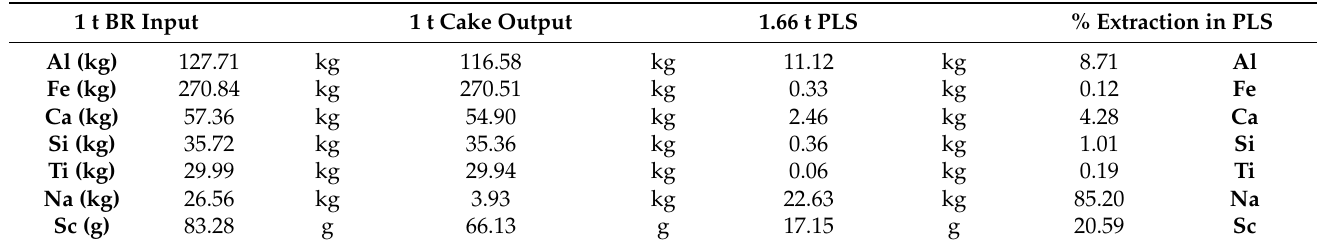
Table 2. Mass balance based on BR leaching campaign to pls and cake production.